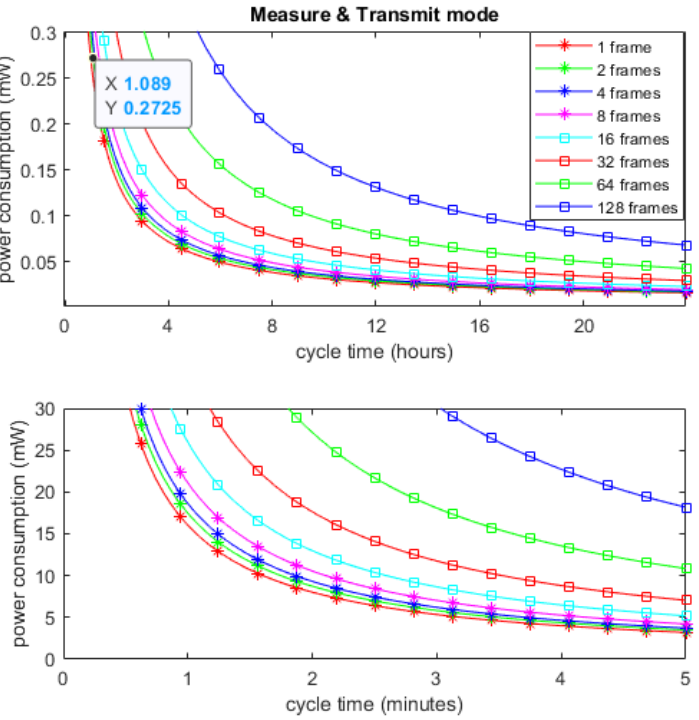
Figure 13. Sensor Node: average power consumption for the Measure & Transmit mode for different number of